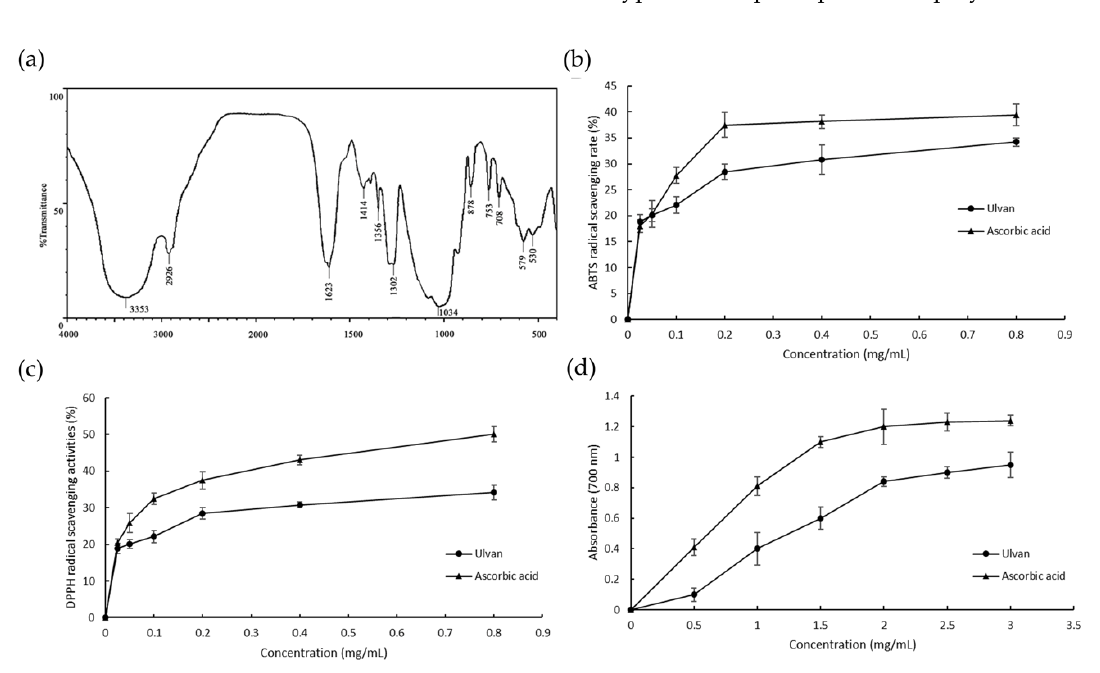
Figure 3. Contour plots showing the e ff ects of the above-mentioned variables on the yield of ulvan. E ff ects of ( a ) extraction time (X 1 ) and power (X 2 ), ( b ) extraction time and water-to-raw-material ratio (X 3 ), ( c ) extraction time and pH (X 4 ), ( d ) power and water-to-raw-material ratio, ( e ) power and pH, ( f ) water-to-raw-material ratio and pH on ulvan yield (Y, %).